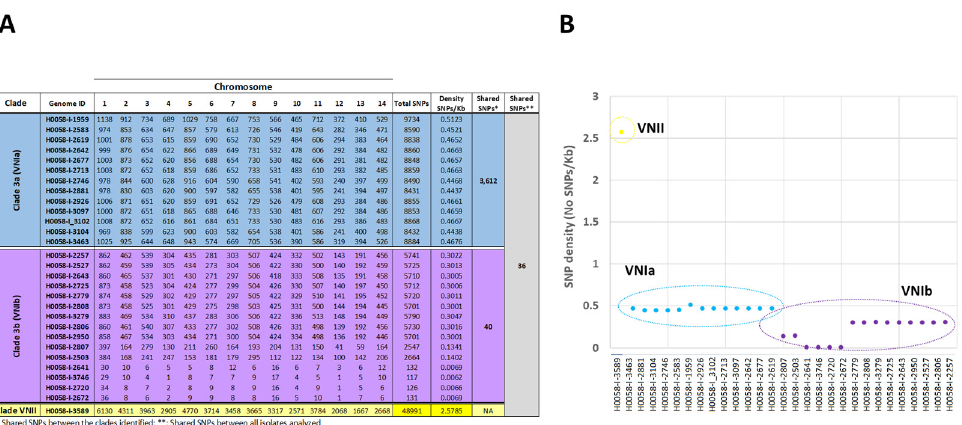
Figure 5. The landscape of SNPs identified in the 29 Colombian Cryptococcus neoformans genomes. ( A ) The figure describes the number of SNPs identified per chromosome, with a potential effect on gene function, in each genome analyzed, as well as the number of shared SNPs in the VNI sub-lineage (VNIa and VNIb) and the number of shared SNPs between the 29 genomes included in the study. ( B ) The density of SNPs in each of the 29 genomes was analyzed.